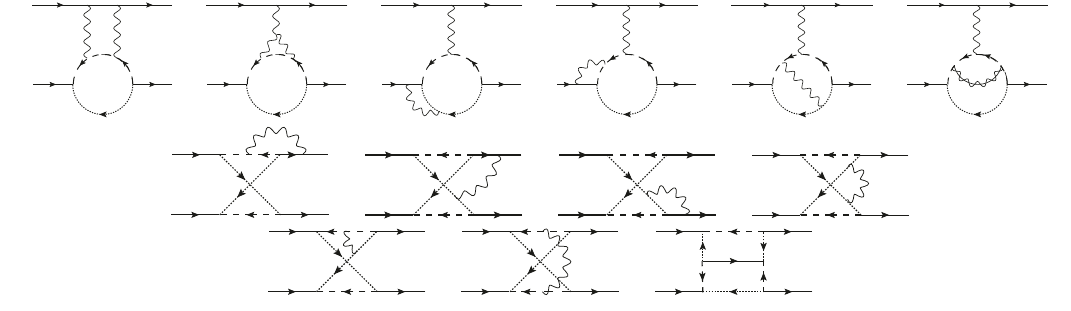
Figure 5 . Diagrams inserted inside two legs of (cid:12)gure 1.